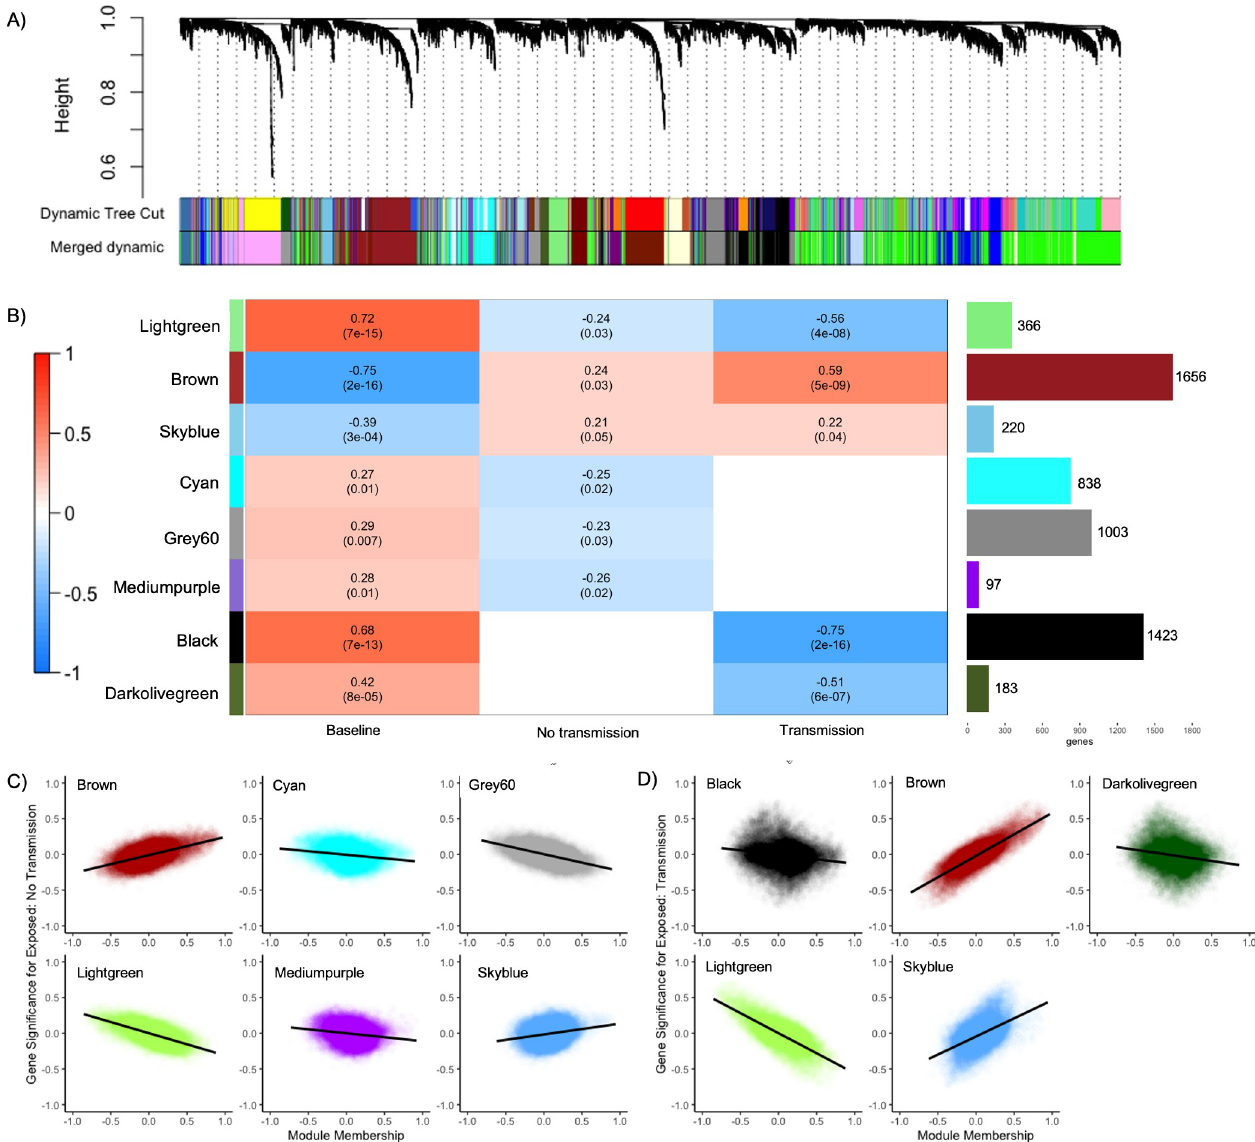
Fig 5. Co-expression analysis identifies 19 gene modules, with eight significantly correlated to Baseline, Transmission and No Transmission. A) Dynamic tree height showing merging of modules with similar expression patterns. Merging resulted in the 43 original modules (Dynamic Tree Cut) being merged into 19 modules (Merged Dynamic). B) Co-expression heatmap showing eight modules that are significantly correlated among Baseline, No Transmission, and Transmission (’Lightgreen’, ’Brown’, ’Skyblue’); Baseline and No Transmission (’Cyan’, ’Grey60’, and ’Mediumpurple’); and Baseline and Transmission (’Black’ and ’Darkolivegreen’). Heatmap fill shows positive (red) to negative correlation (blue). The top number in each cell shows the correlation strength and the bottom number shows module significance to Baseline, No Transmission, and Transmission. Bar graph to the right shows the number of genes within each module. C) The six modules that are significantly correlated between Baseline and No Transmission showing the module membership and gene significance. D) The five modules that are significant between Baseline and Transmission showing the module membership and gene significance. For C and D: Y-axis shows gene significance that is the absolute value of the correlation between the gene and disease outcome. X-axis shows the module membership which is the correlation of the module eigengene and the gene expression profile. gene = PREDICTED: uncharacterized protein LOC107335116) were all significantly corre- lated (p � 0.05) across Baseline, No Transmission, and Transmission (Fig 5B–5D). These mod- ules were significantly enriched (FDR, p < 0.01) for multiple GO Biological Processes, Cellular Components, and Molecular Functions with 58 terms for the ‘Brown’ module, 1 for ‘Skyblue’,